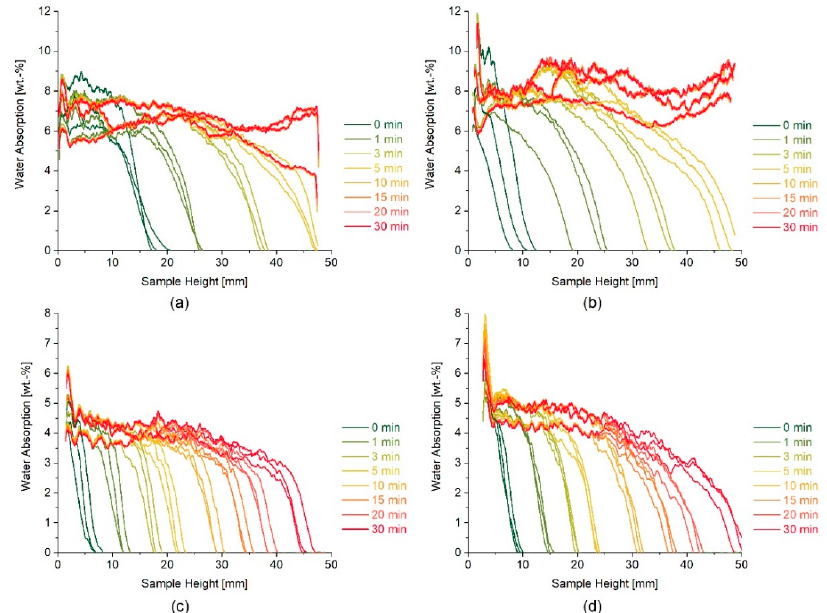
Figure 4. Neutron studies of sound ( a ) and artificially aged ( b ) water absorption kinetics (reported as wt. % and as a function of the sample height at intervals of 1, 3, 5, 10, 15, 20, 25 and 30 min) for three stone specimens of St. Margarethen Limestone, as well as sound ( c ) and artificially aged ( d ) water absorption curves of three stone specimens of Schlaitdorf Sandstone.